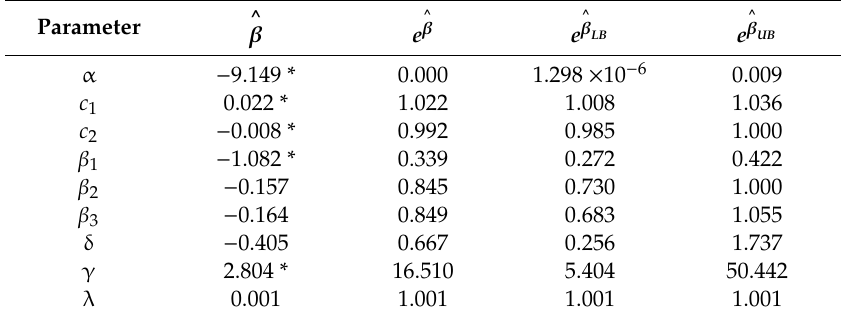
Table2. ParametricestimatedvaluebasedonthecollecteddataincludingA(H7N9)cases, meteorological factors, the number of LPMs, population density and media coverage and Poisson regression